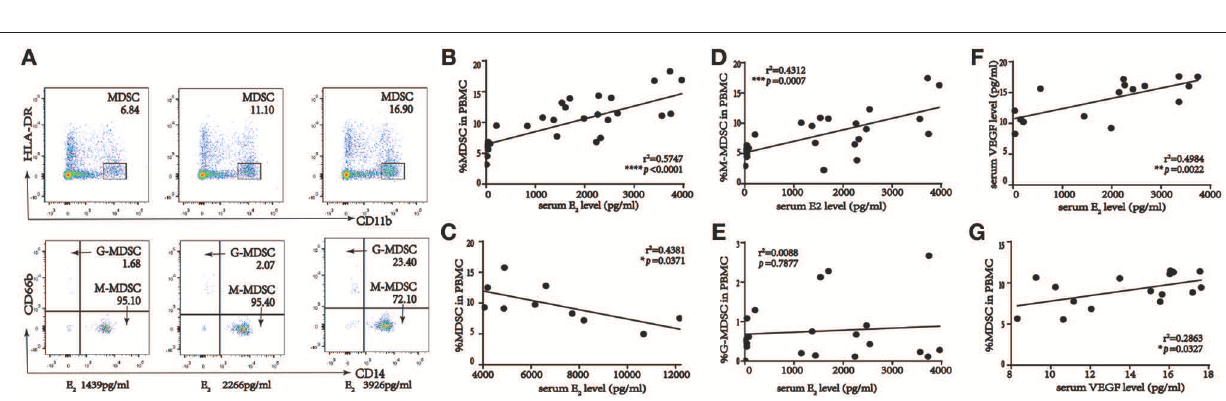
FIGURE 1 | Flow chart of the study. Fifty-four patients were included, of which four patients were excluded from the analysis due to the exclusion criteria. Serum E 2 level and percentage of MDSC among PBMC were detected in the remaining 50 patients at a random time-point during controlled ovarian stimulation, and serum VEGF level was detected ( n = 23). Then, serum E 2 level and percentage of MDSC in PBMC were detected on the embryo transfer day and pregnancy outcome visit were done in the patients of 2 good-quality frozen embryo transfer group ( n = 16). Finally, we did bioinformatic analysis to predict the interaction between E 2 , VEGF and MDSC, and the probability of signal pathway.